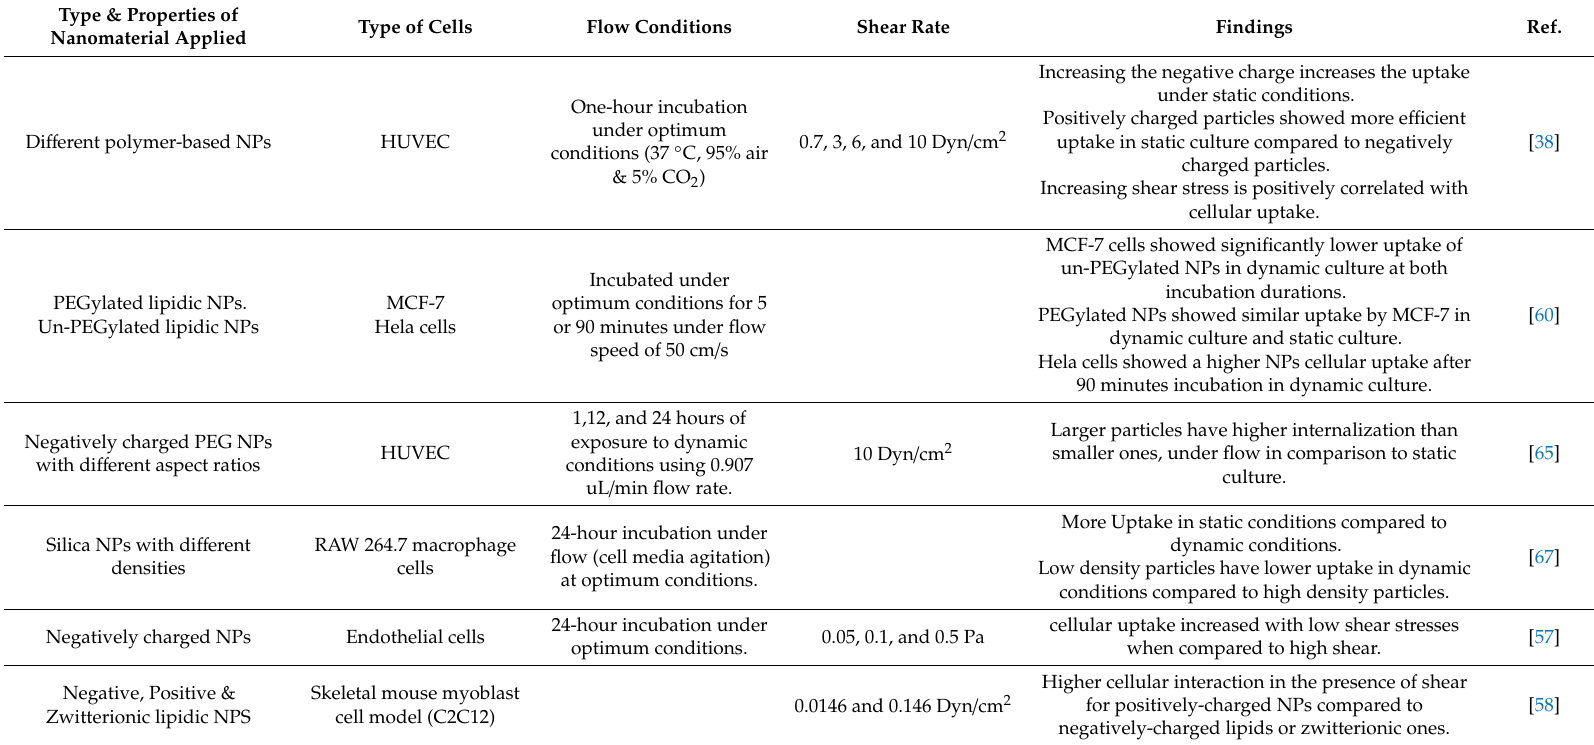
Table 2. Summary of findings on nanoparticle—cell interactions under shear